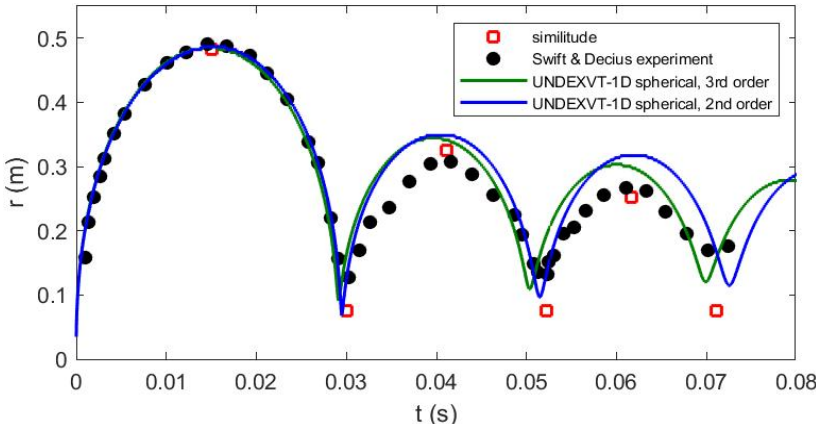
Figure 22. Variation of the bubble radius over time, for 0.66 lb TNT exploding 300 ft below the surface, for multiple bubble periods.